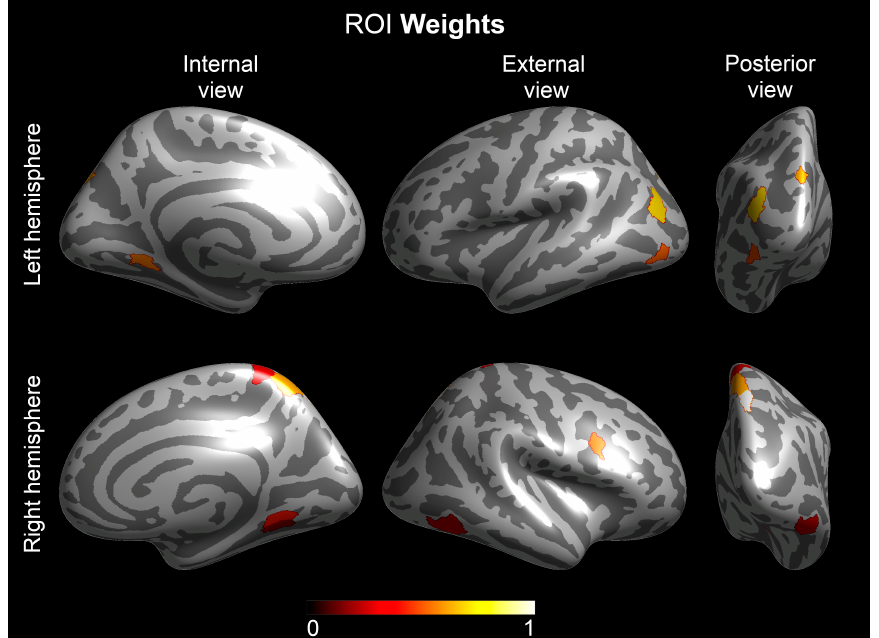
Figure 2. ROI weights for the 11 ROIs that provide the highest GL–MKL classifier performance. ROIs from the HCP-MMP1 atlas [129] were selected by the MKL to classify TRs and children with DD. ROI weights were scaled to a maximum value equal to 1, and the color of the regions varies from black (minimum ROI weight) to white (maximum ROI weight).